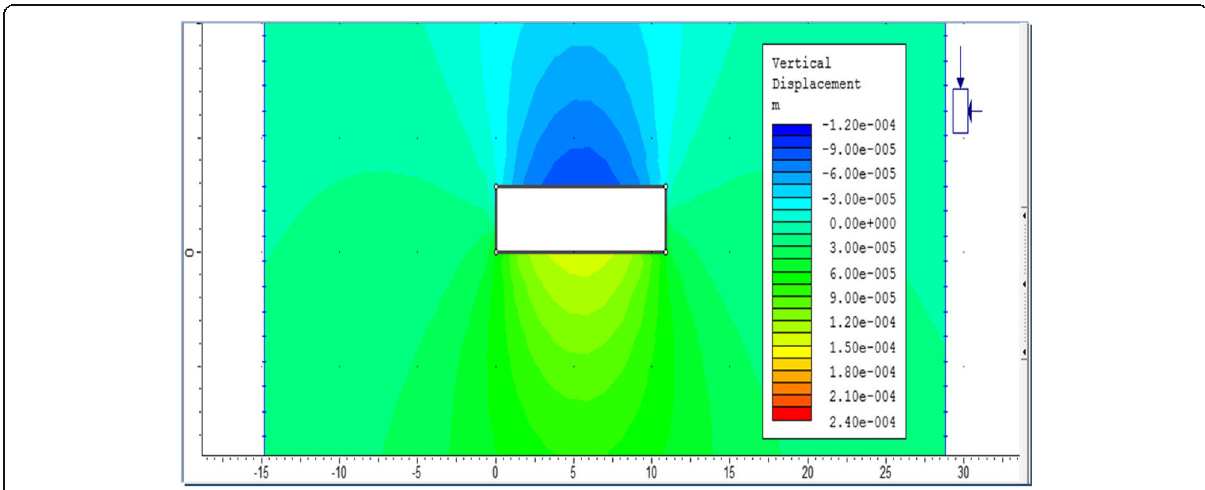
Fig. 19 Vertical displacement of the ceiling and sidewalls of northern Chamber. Examine 2D